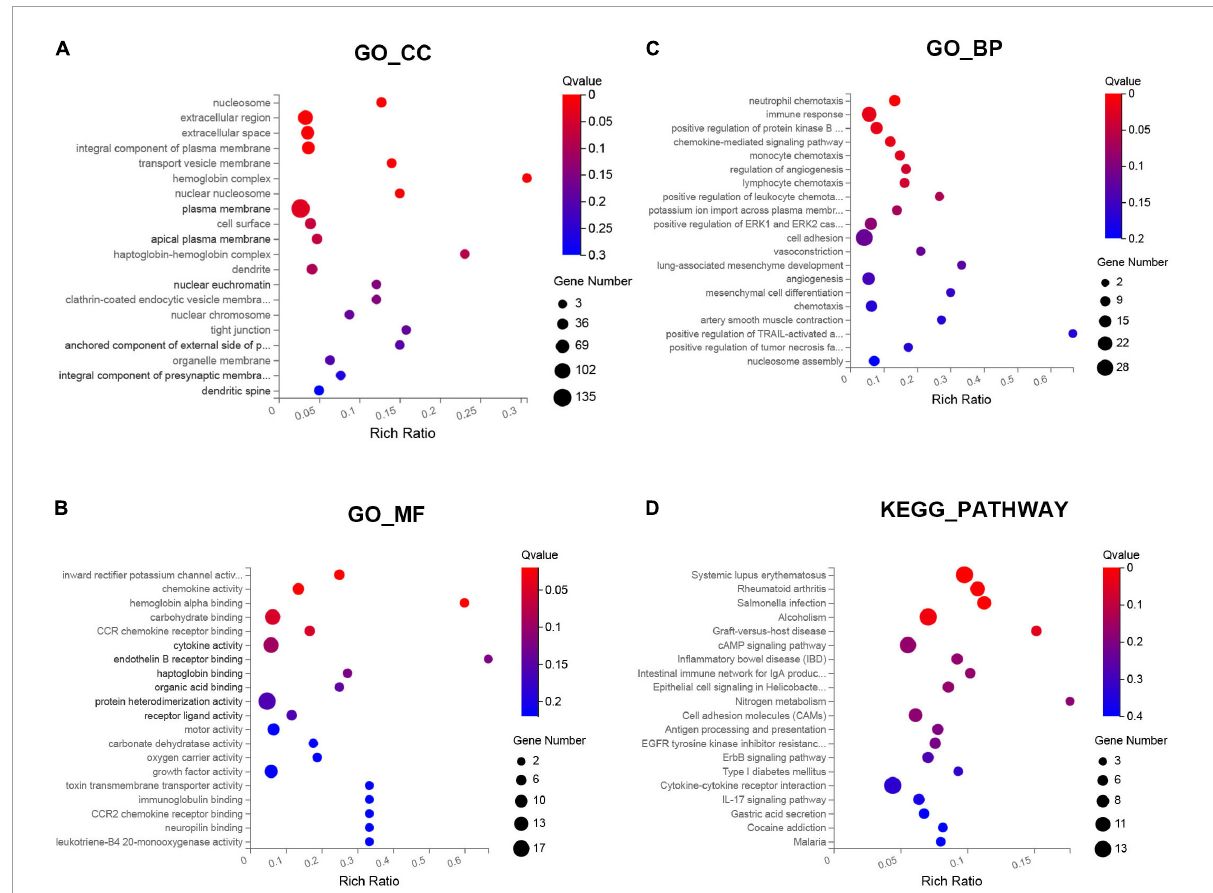
FIGURE2 Gene ontology (GO) and Kyoto encyclopedia of genes and genomes (KEGG) pathway enrichment analysis of the differentially expressed genes (DEGs) between SSH and SRH in the biological processes (BPs), cellular components (CCs), and molecular functions (MFs). (A) GO-CC, (B) GO-MF, (C) GO-BP, and (D) KEGG